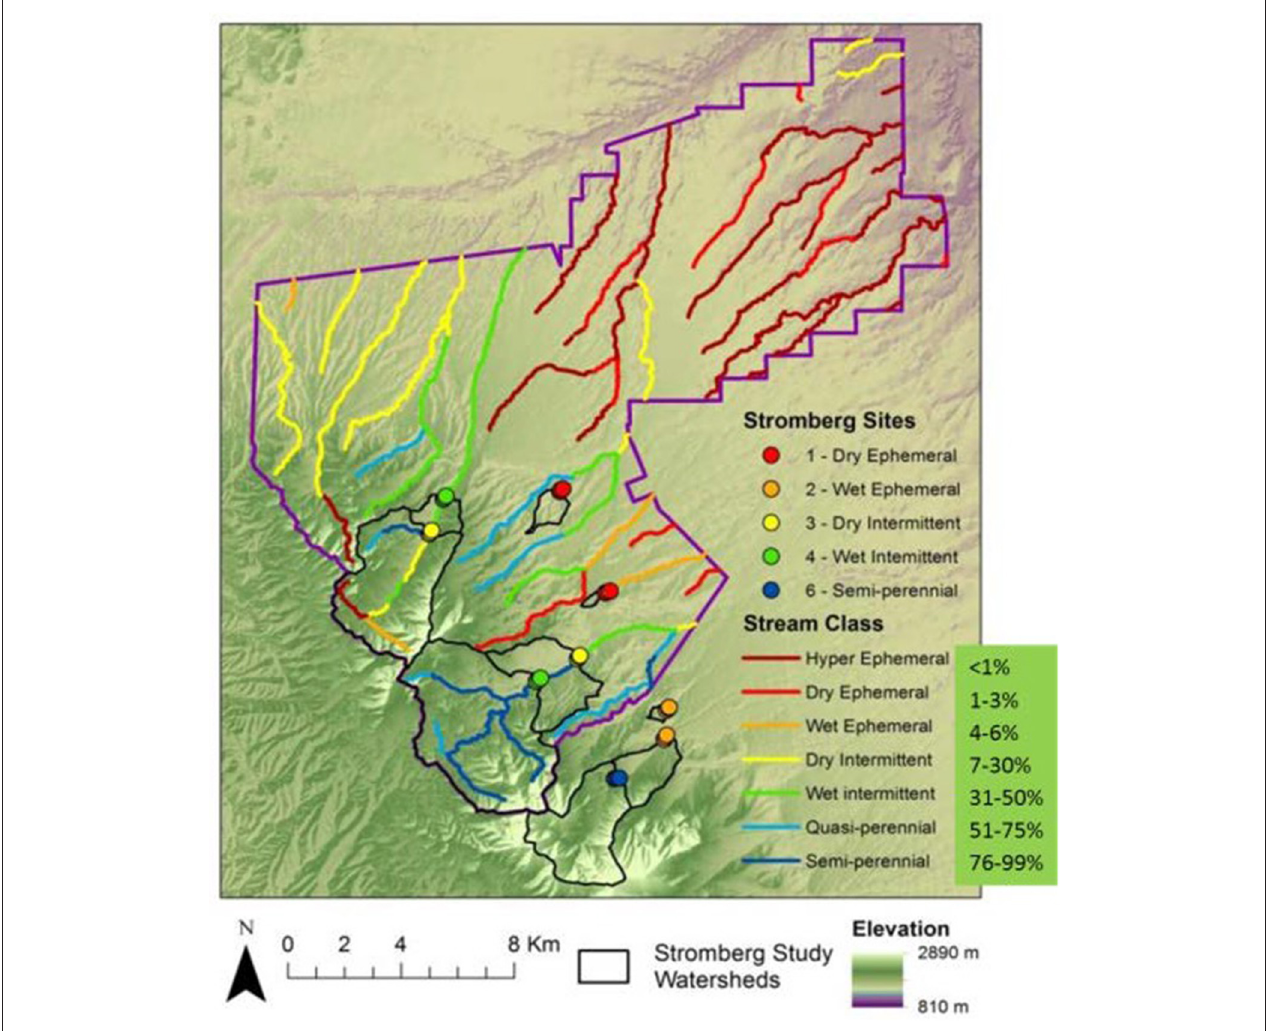
FIGURE 10 | Mapping of observed stream classifications (this study -labeled Stromberg Sites) compared to Levick et al. (2018). We note that hyper ephemeral streams were not captured by our classification scheme and Levick et al. (2018) 3 and 4 types were lumped into the wet-intermittent classes given the rarity of class 3 (2% total stream reaches) such that only 7 classes are